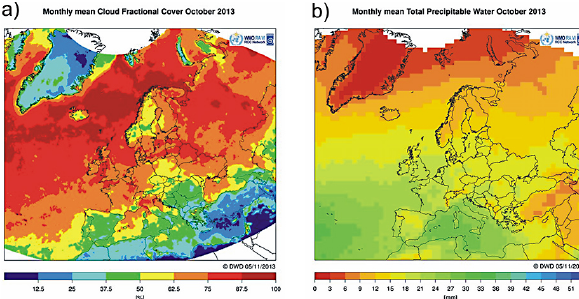
Figure 2. Monthly means of cloud fractional cover (a) and total precipitable water (b) for October